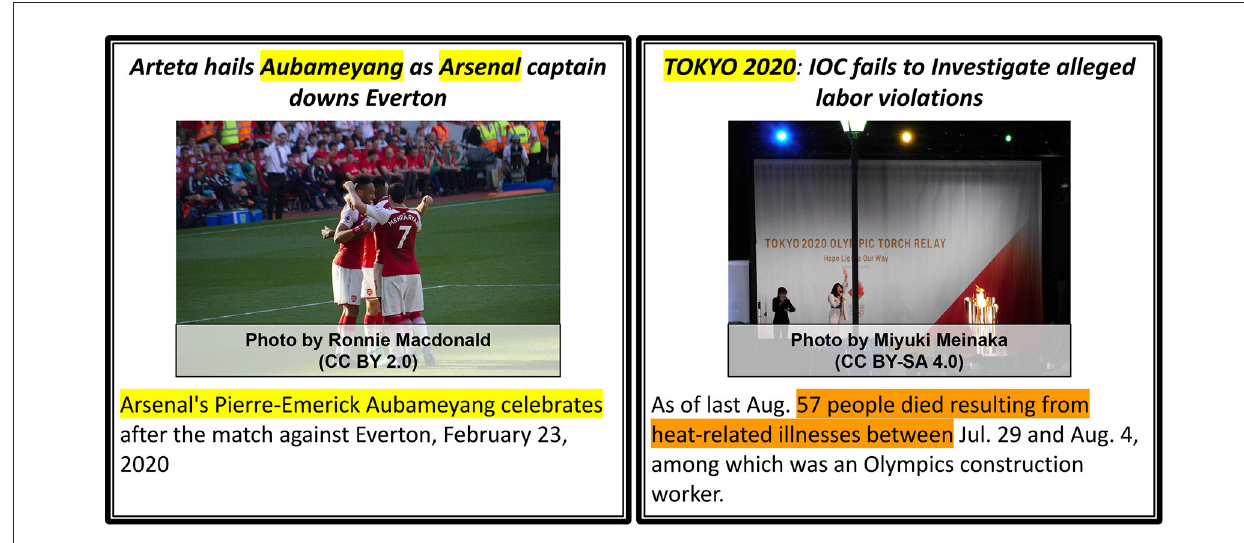
FIGURE1 Examples of image-text pairs from news. Left : An additive relationship between image and text. Right : A stock photograph uncorrelated or contradictory to the text. Highlighted text shows the contradicting and overlapping aspects within the images respectively. In general, an image can have relations to text in different parts of an article, but here we focus on the headline (bold) and caption of the image as these already exhibit some of the complexity